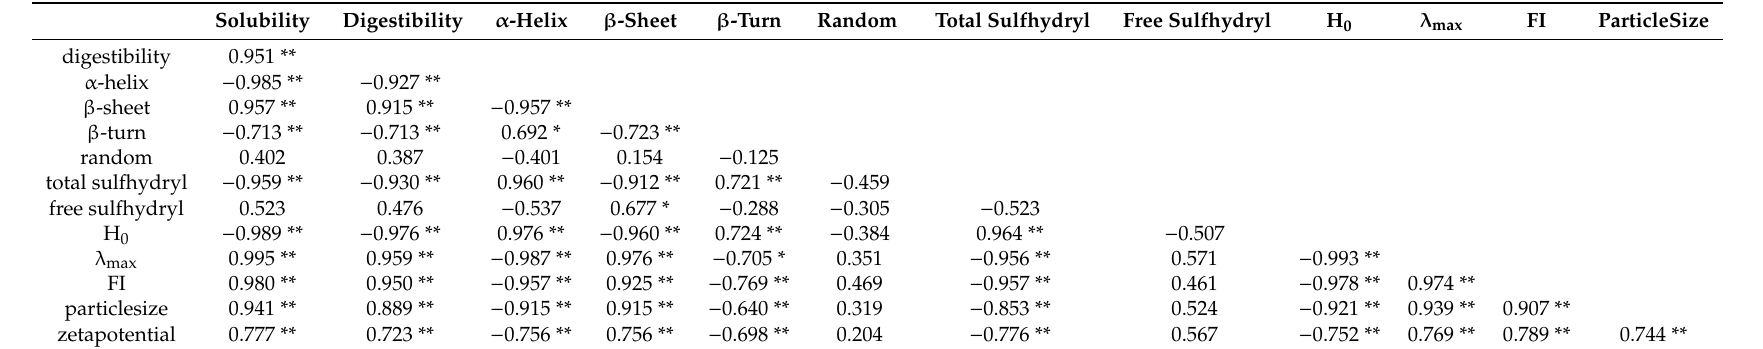
Table 3. Pearson correlation of potato protein structure and functional